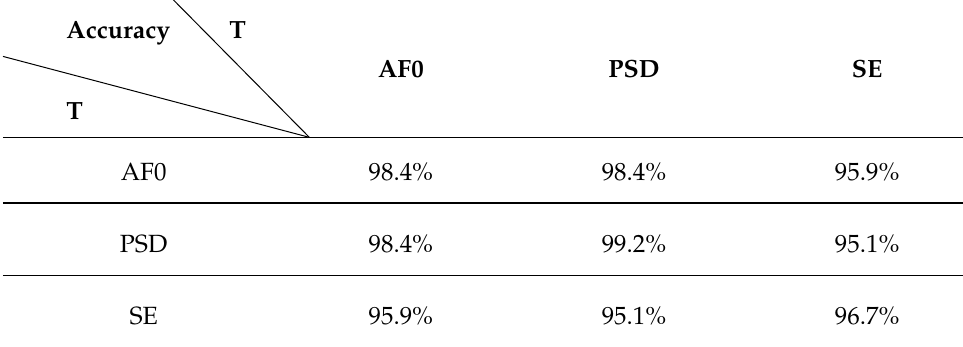
Table 1. Accuracy comparisons of the MGRALN when K = 3 on the dataset I.